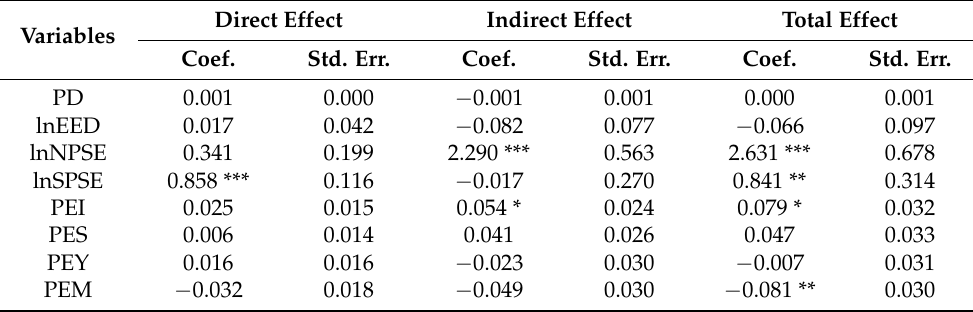
Table 8. Direct, indirect, and total effects of SDM with spatial fixed effects. Direct Effect Indirect Effect Total Effect Variables Coef. Std. Err. Coef. Std. Err. Coef. Std. Err. PD 0.001 0.000 − 0.001 0.001 0.000